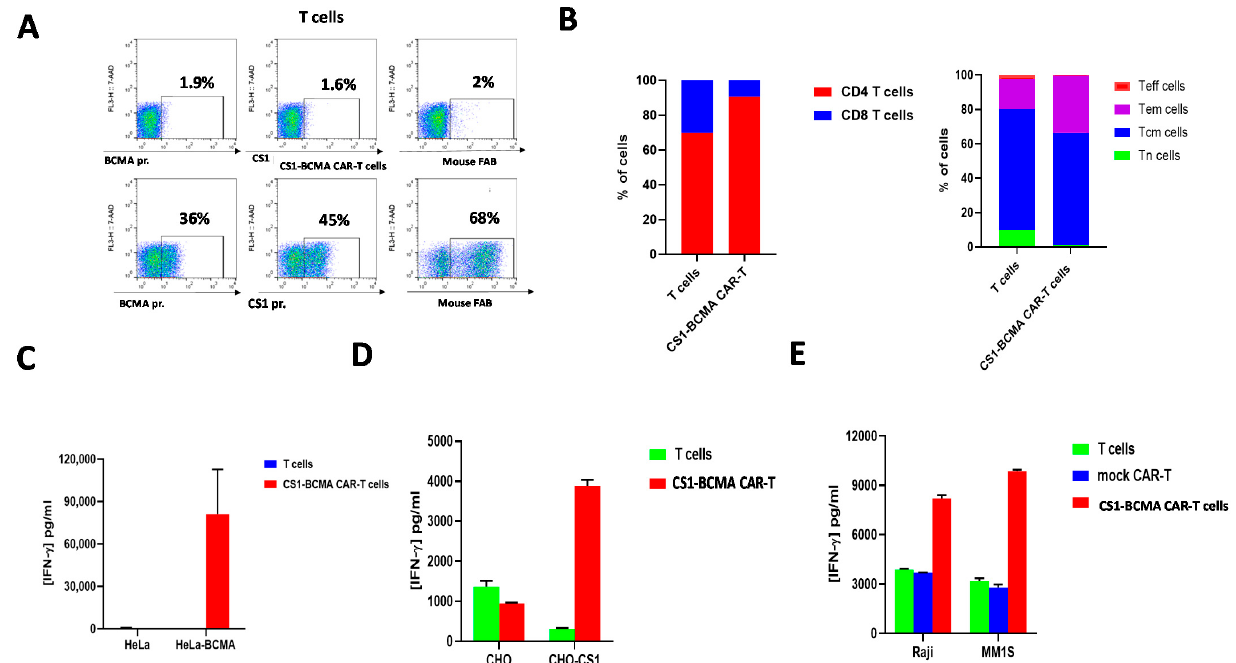
Figure 4. Manufactured with G-Rex system, bispecific CS1-BCMA CAR-T cells express high functional activity with CS1 and BCMA-positive target cells. ( A ) FACS staining detects CS1 scFv and BCMA scFv-positive CAR-T cells. FACS was performed on T cells (top panel) and CS1-BCMA CAR-T cells (bottom panel) with biotinylated recombinant BCMA (left) and CS1 proteins (middle) and mouse F(ab’)2 antibody (right). ( B , C ) The percentage of CD4+/CD8+ cells is shown in the left panel, and the percentage of cells with a T N , T CM , T EM , and T EF phenotype is shown in the right panel. ( C ) Manufactured CS1-BCMA CAR-T cells secreted IFN-gamma with Hela-BCMA target cells. ( D ) CS1-BCMA CAR-T cells secreted IFN- gamma with CHO-CS1-positive target cells. ( E ) CS1-BCMA-CAR-T cells had significantly higher levels of IFN-gamma with BCMA/CS1-positive target cells than with T and Mock-CAR-T cells: Raji cells are BCMA-positive cells and MM1S cells are CS1-BCMA-positive cells. ( C – E ) p < 0.05, Student’s t -test, CS1-BCMA CAR-T cells versus Mock CAR-T cells.